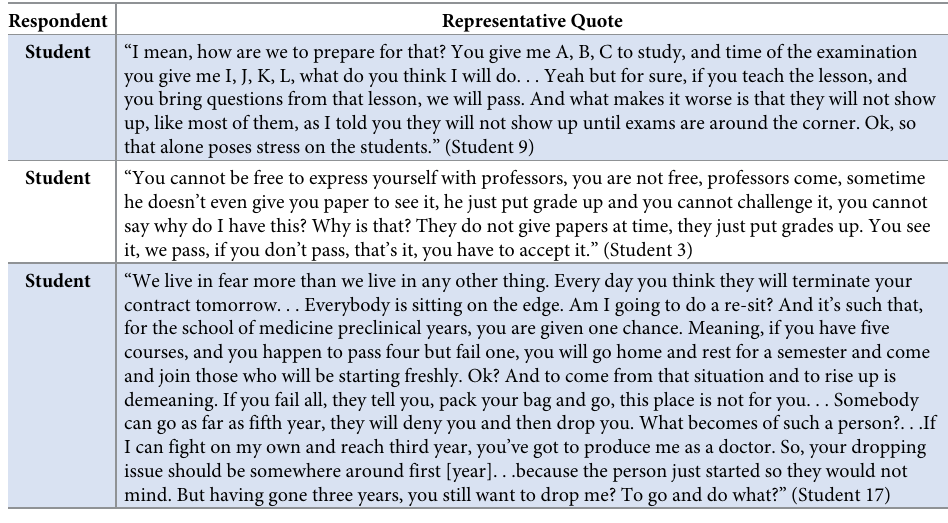
PLOS Global PublicHealth | https://doi.org/10.1371/journal.pgph.0001610 March 8,